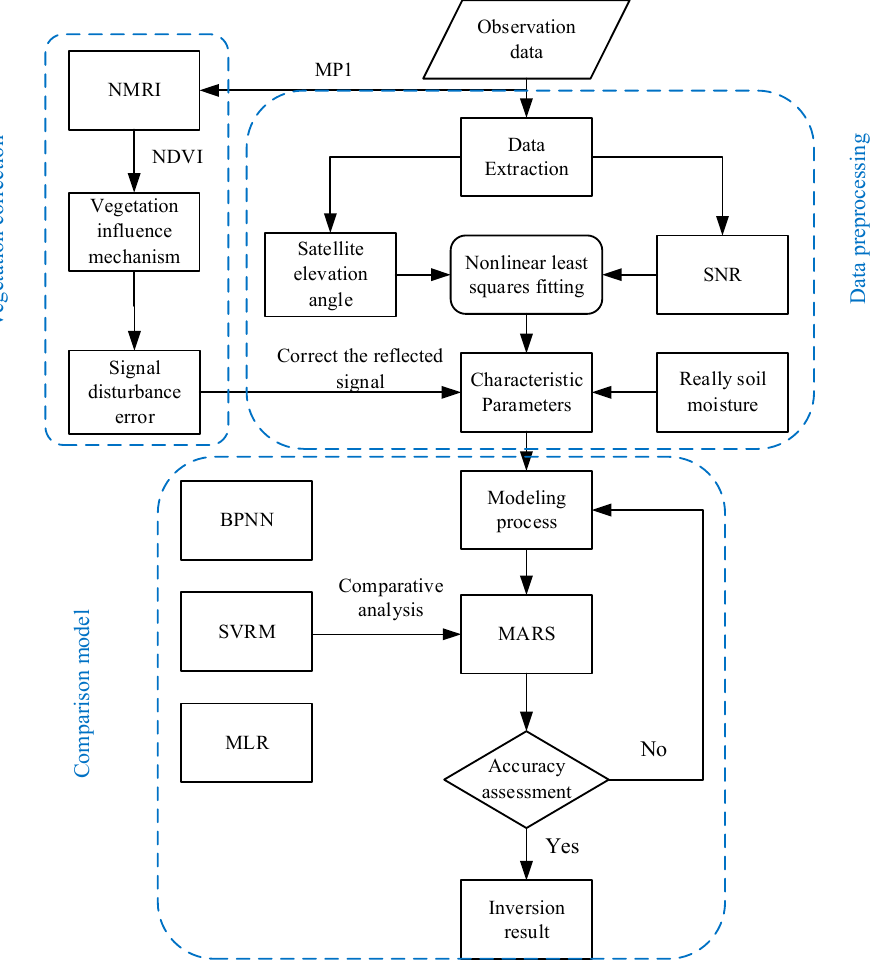
Figure 3. Technical process of soil moisture inversion.